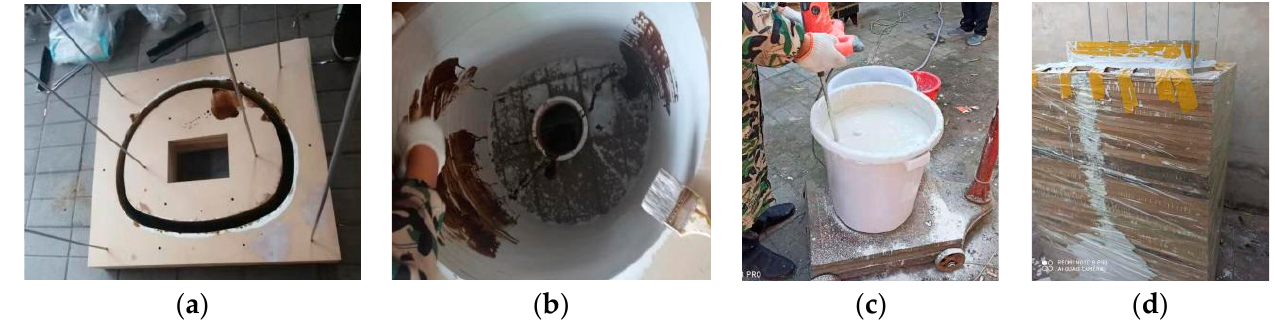
Figure 5. The production process of the lining model: ( a ) positioning and assembling; ( b ) brushing the oil; ( c ) slurry stirring; ( d ) perfusion model.